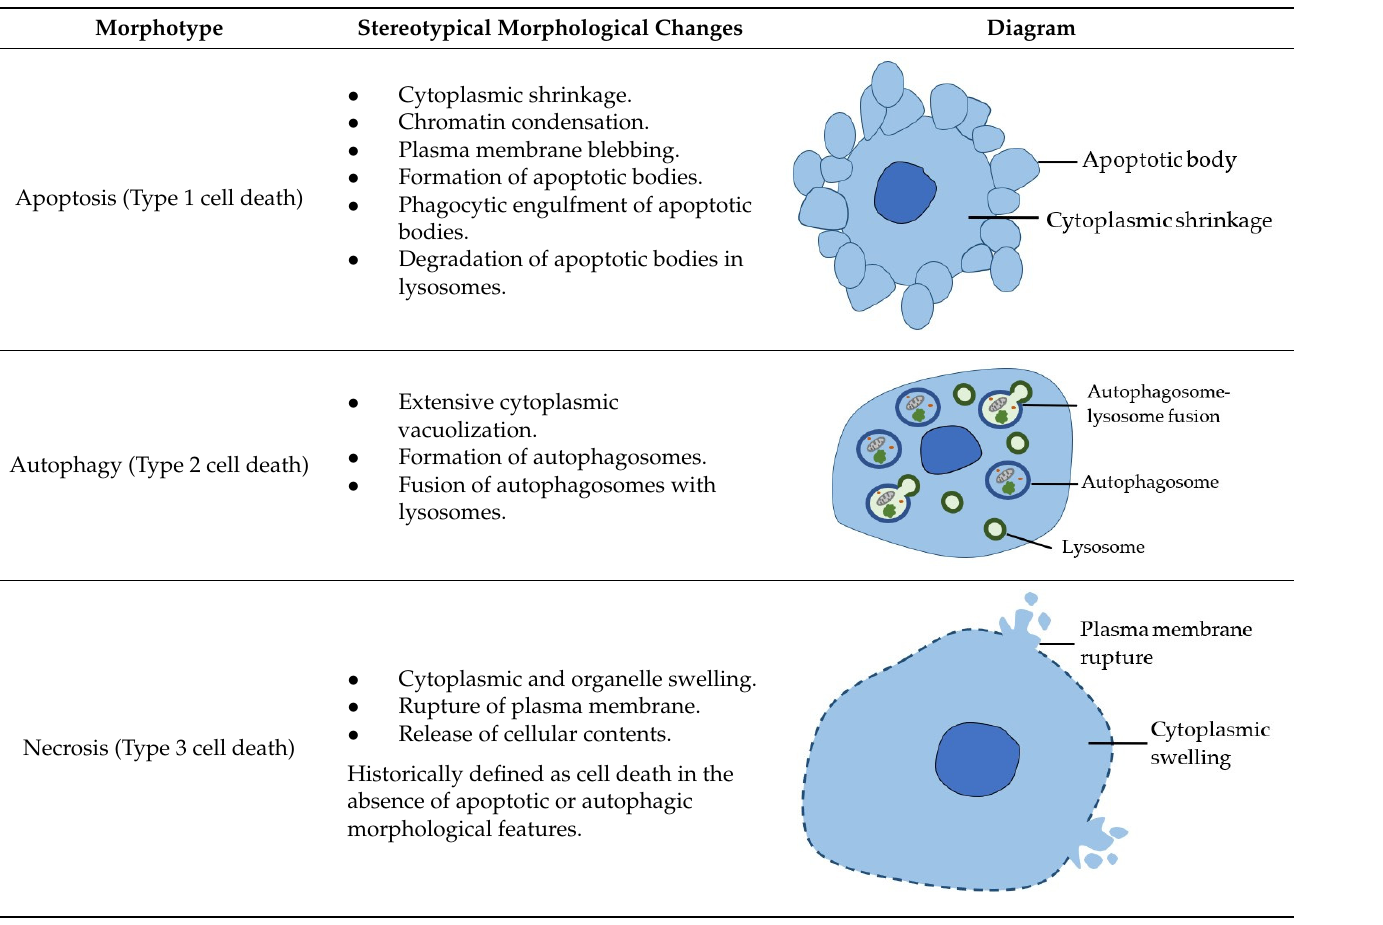
Table 2. Mechanistic classification of cell death (adapted from Galluzzi et al.; 2018)